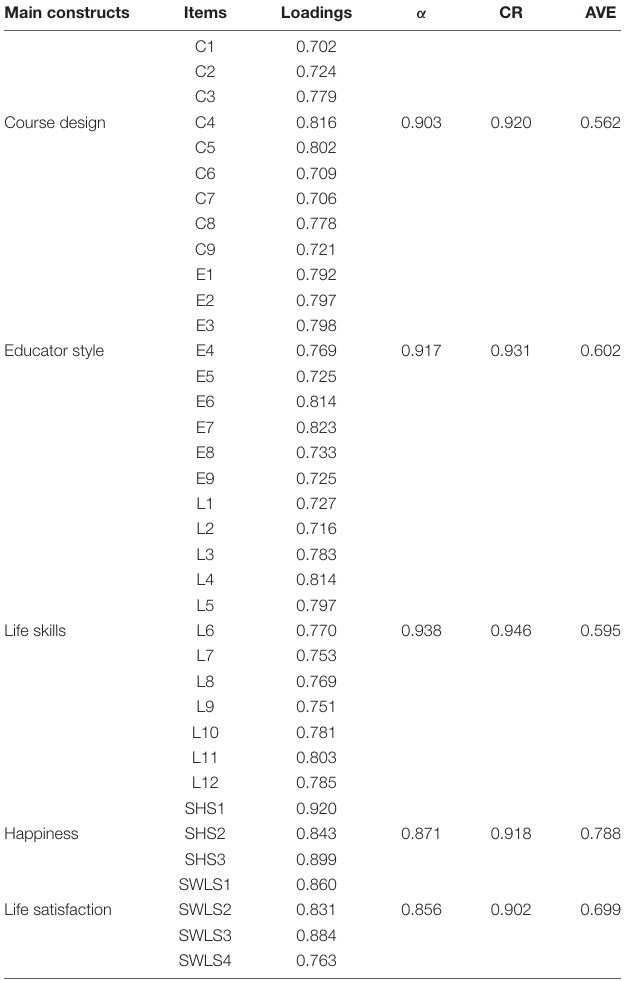
( Table 5 ). Considering the effect size for the influence of course design on life skills (f 2 = 0.372, Table 5 ), the result exceeded a f 2 was 0.018 which is considered